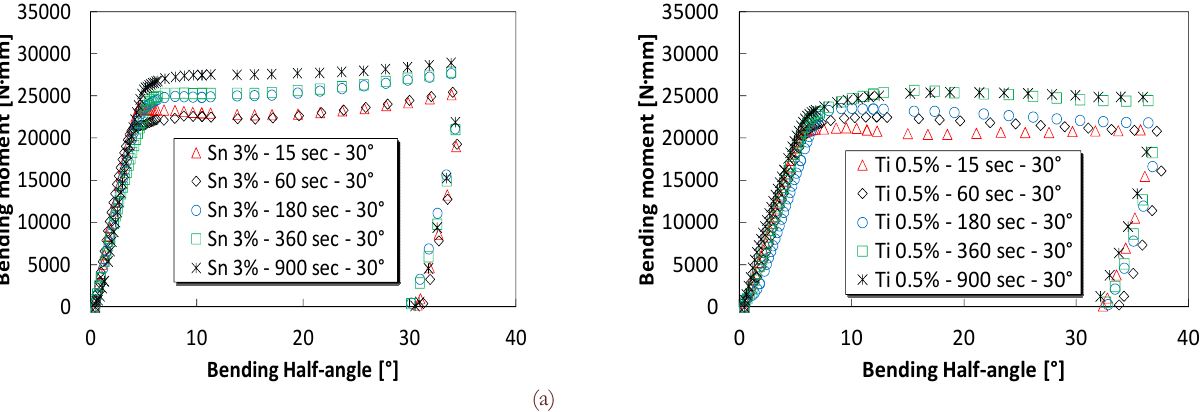
Figure 4: Bending behavior of galvanized specimens: a) galvanized in Zn-Sn bath, b) galvanized in Zn-Ti bath. At high values of deformation Zn-Sn coatings show an increase of strength, whereas coatings from Zn-Ti bath show a slight decrease (Fig. 4a and Fig. 4b). Highest values of strength are observed in Zn-Sn coatings. In terms of elastic recovery, coatings from Zn-Sn are characterized by a fully recover at investigated deformation, but Zn-Ti coatings show a loss of recover property as shown in Fig.